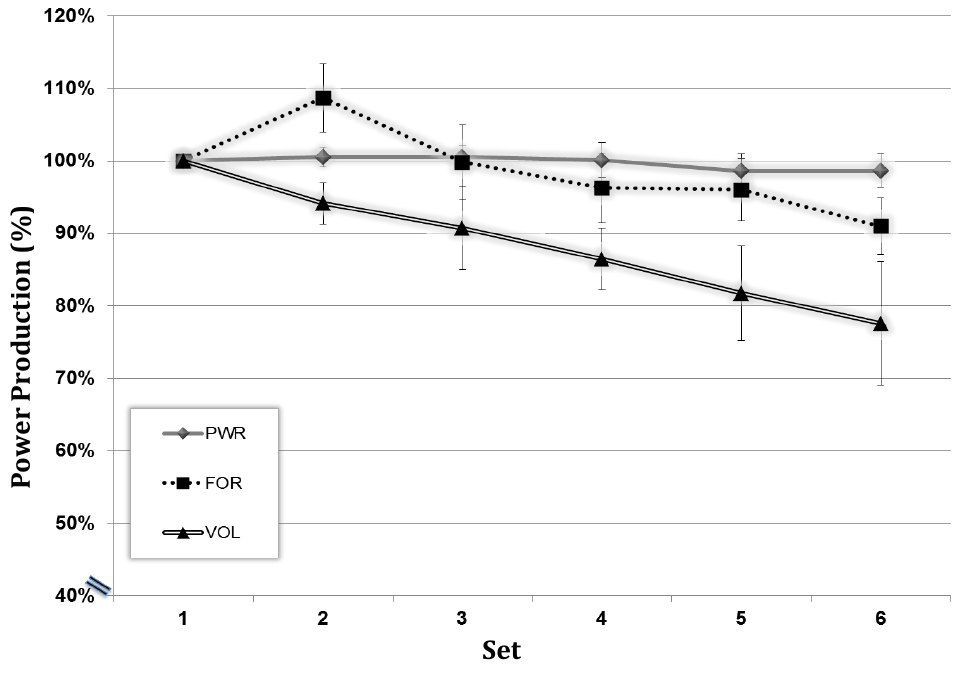
Figure 3. Mean performance over